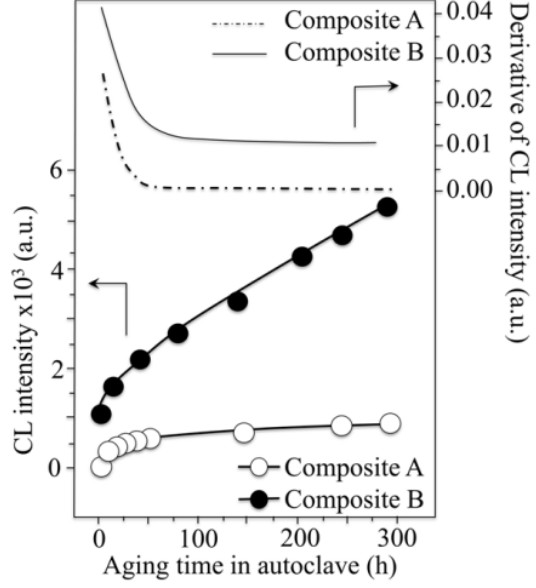
Figure 13. Trends found for CL intensity of bands related to oxygen deficiency in the Al O matrix as a function of exposure time in autoclave for both Composites A and B. 2 3 The size of the used symbols corresponds to the standard deviation of the measured CL intensity. The derivatives of the curves are also shown, which represent the vacancy formation rate on the